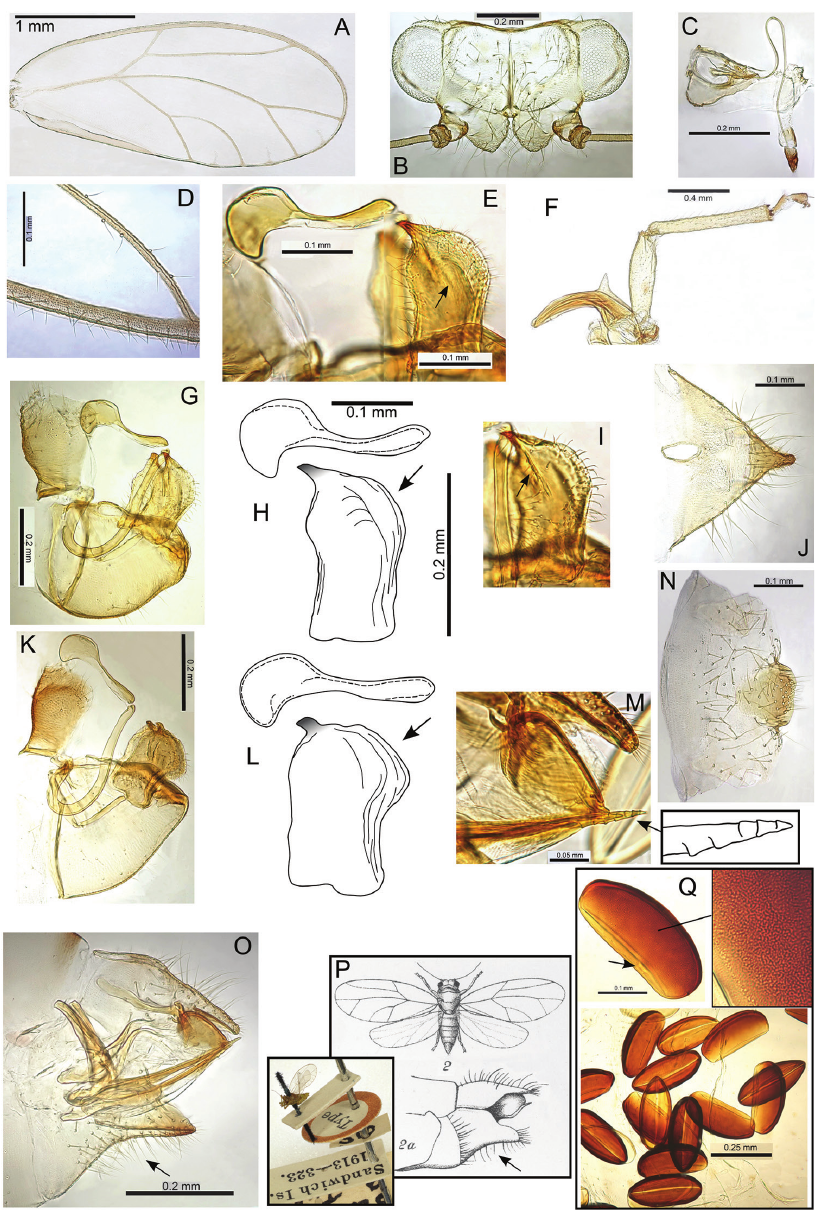
Figure 21. Pariaconus iolani . A fore wing B head C proboscis D fore wing detail E aedeagus and para- mere (central ridge indicated), form iolani F hind leg G, H, I form iolani : G male terminalia H aedeagus and paramere (posterior shoulder indicated) I paramere (interior view, central ridge indicated) J female proctiger (dorsal view) K, L form scapulus : K male terminalia L aedeagus and paramere (posterior shoul- der indicated) M ovipositor (serrations indicated) N female subgenital plate (ventral view) O female ter- minalia (concave subgenital plate indicated) P original illustration (Kirkaldy, 1902) (concave subgenital plate indicated) and female lectotype (inset) Q eggs (pedicel and microsculpturing